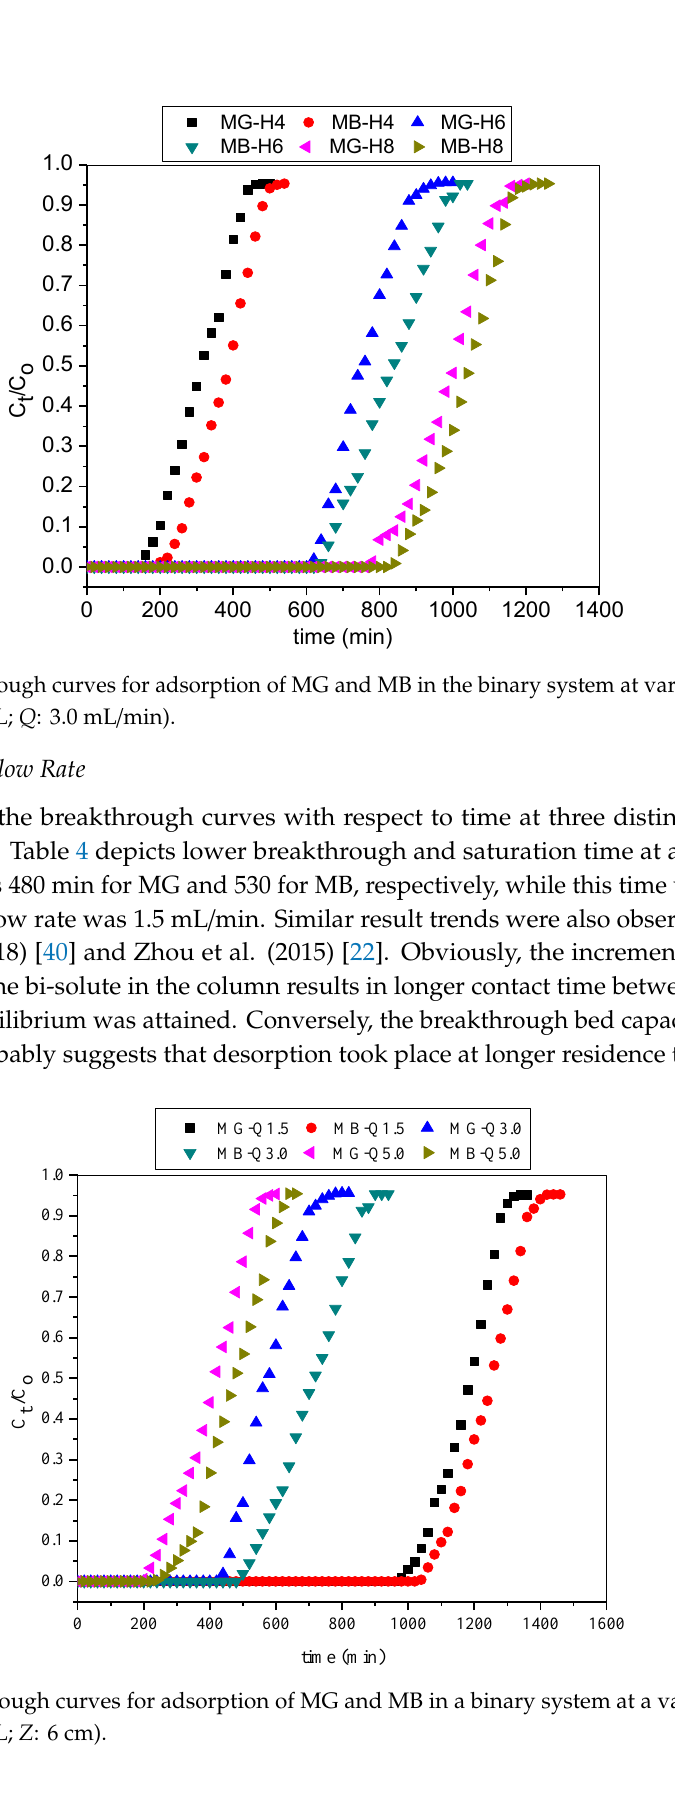
10 of 18 Figure 7. Breakthrough curves for adsorption of MG and MB in the binary system at varying initial concentrations (pH: 9; Z : 6 cm; Q : 3.0 mL/min). 3.4. Effect of Adsorbent Bed Height The influence of column bed height (mass of T-PAA) on binary adsorption of cationic dye was investigated. Figure 8 shows the breakthrough curves as a function of time at varied bed height (4, 6, and 8 cm). As depicted by Table 4, the breakthrough and saturation time increased with increasing bed depth. The breakthrough time increases from 310 min to 1010 min, and 380 min to 1040 min, respectively, for MG and MB when bed depth increases from 4 cm to 8 cm. This is due to an increase